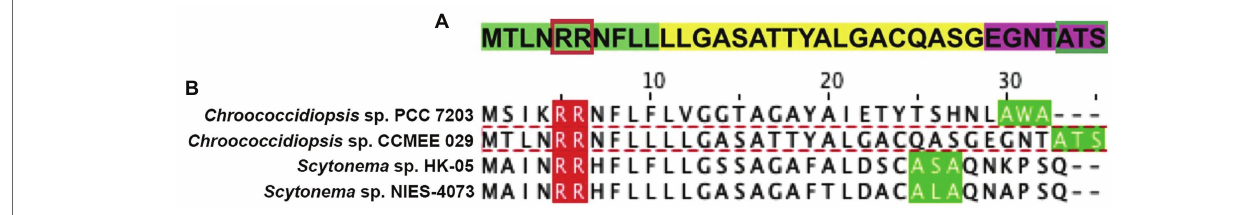
FIGURE 2 | Predicted Tat signal peptide at the N-terminal of MnSOD (SodA2.1) of Chroococcidiopsis sp. CCMEE 029. (A) Tripartite structure with the positively charged n-region (highlighted in green) and twin-arginine dipeptide (boxed in red), the central hydrophobic h-region (yellow) and the c-region with peptidase recognition site (purple) and cleavage site (boxed in green). Alignment of SodA2.1 of Chroococcidiopsis sp. 029 and cyanobacterial MnSOD with a Tat signal peptide. (B) Chroococcidiopsis sp. PCC 7203 (UniProt entry K9TVN2), Scytonema sp. HK-05 (UniProt entry A0A1Z4IPS3) and Scytonema sp. NIES-4073